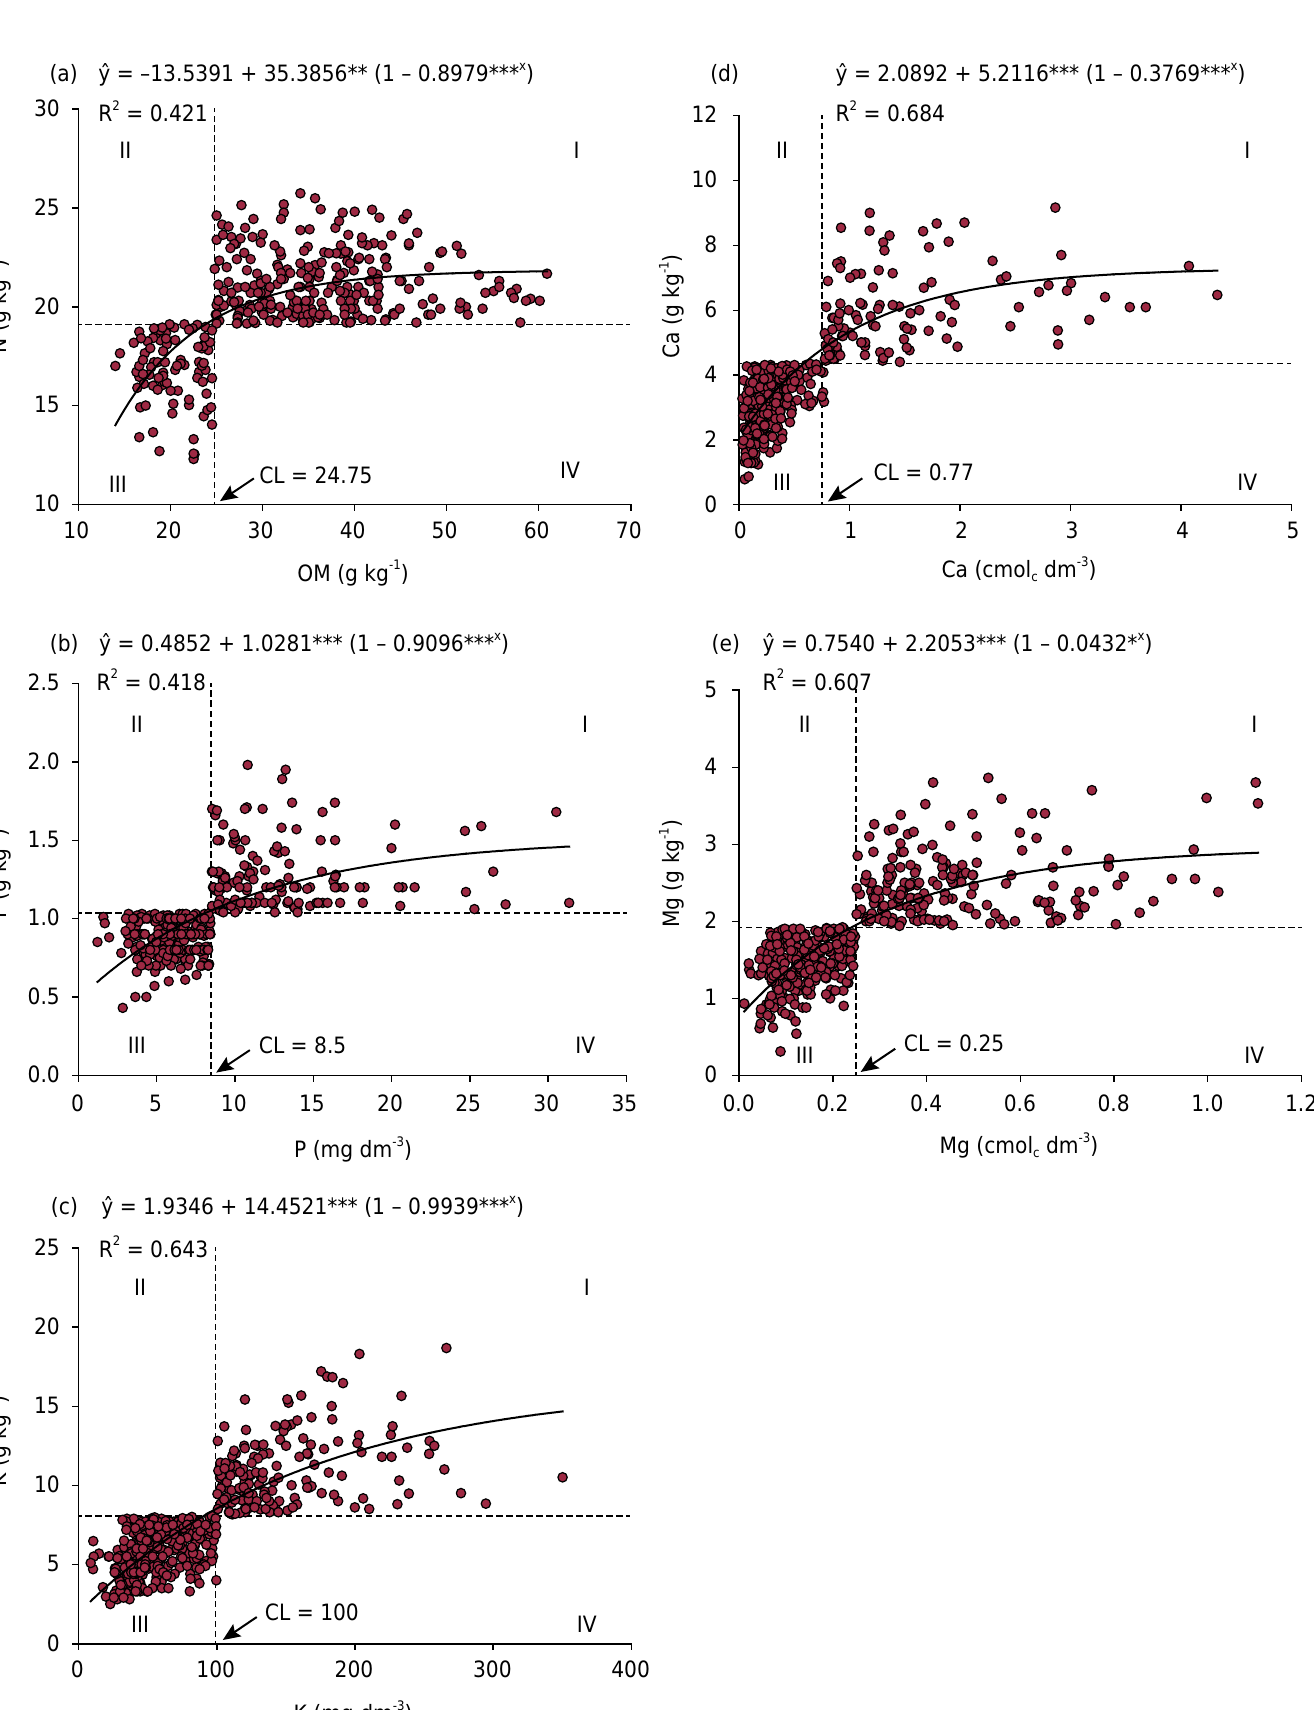
Figure 4. Relationship between N (a), P (b), K (c), Ca (d), and Mg (e) contents in eucalyptus leaves as a function of OM, P, K + , Ca 2+ , and Mg 2+ contents in soil (0.00-0.20 m), respectively, obtained by the Quadrant Diagram of the plant-soil Relationship (QDpsR) method. CL: critical